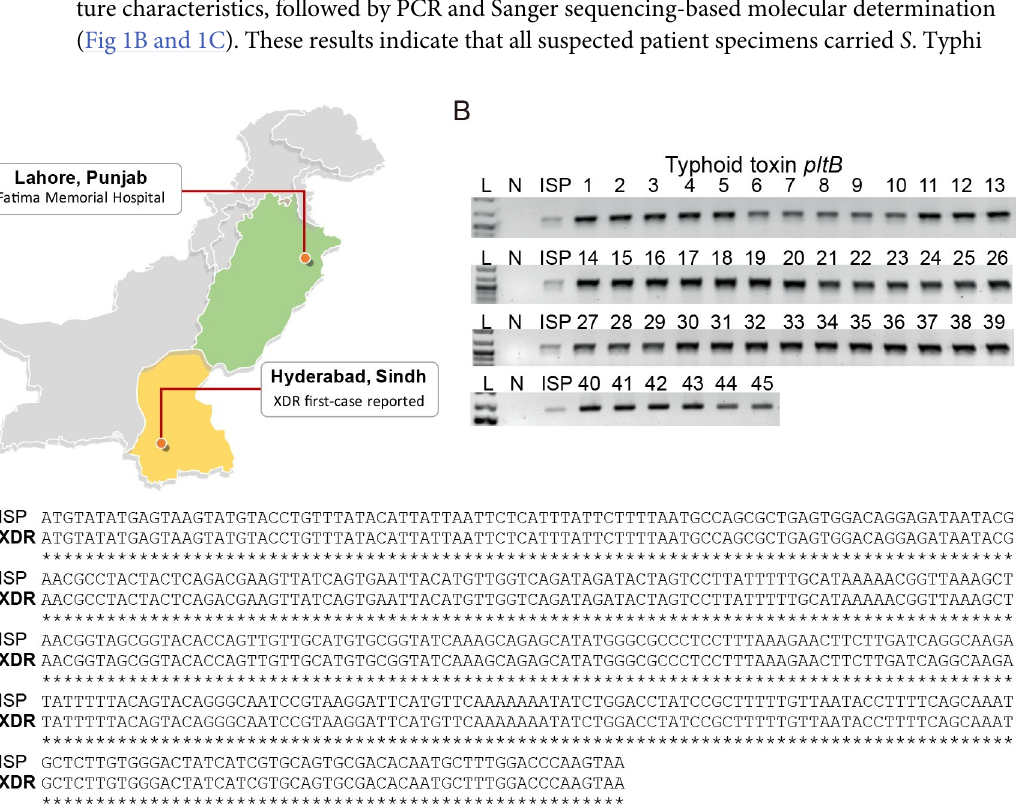
PLOS ONE | https://doi.org/10.1371/journal.pone.0257744 September 28,